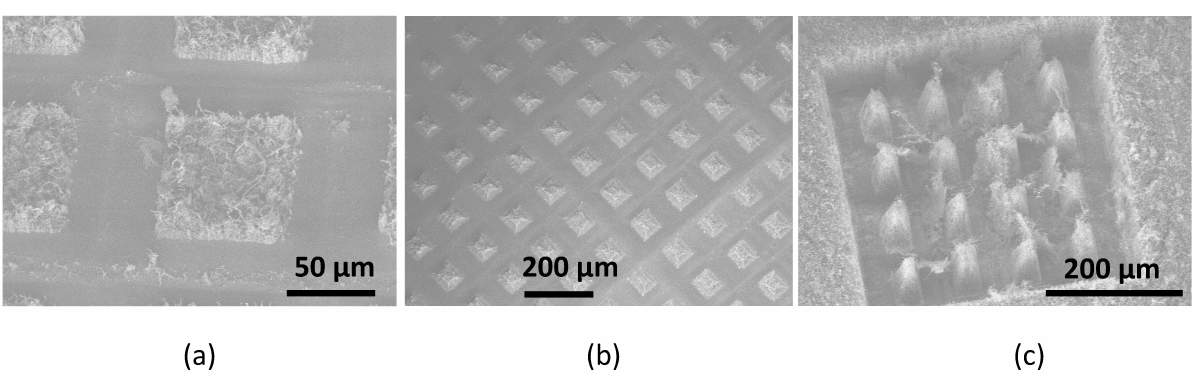
Figure 3. SEM images of the CNT vertical array structure after the etching post-process with the following parameters, with 100 µm × 100 µm plot size expected: ( a ) Pattern 1, ( b ) Pattern 2 and ( c ) Pattern 3.